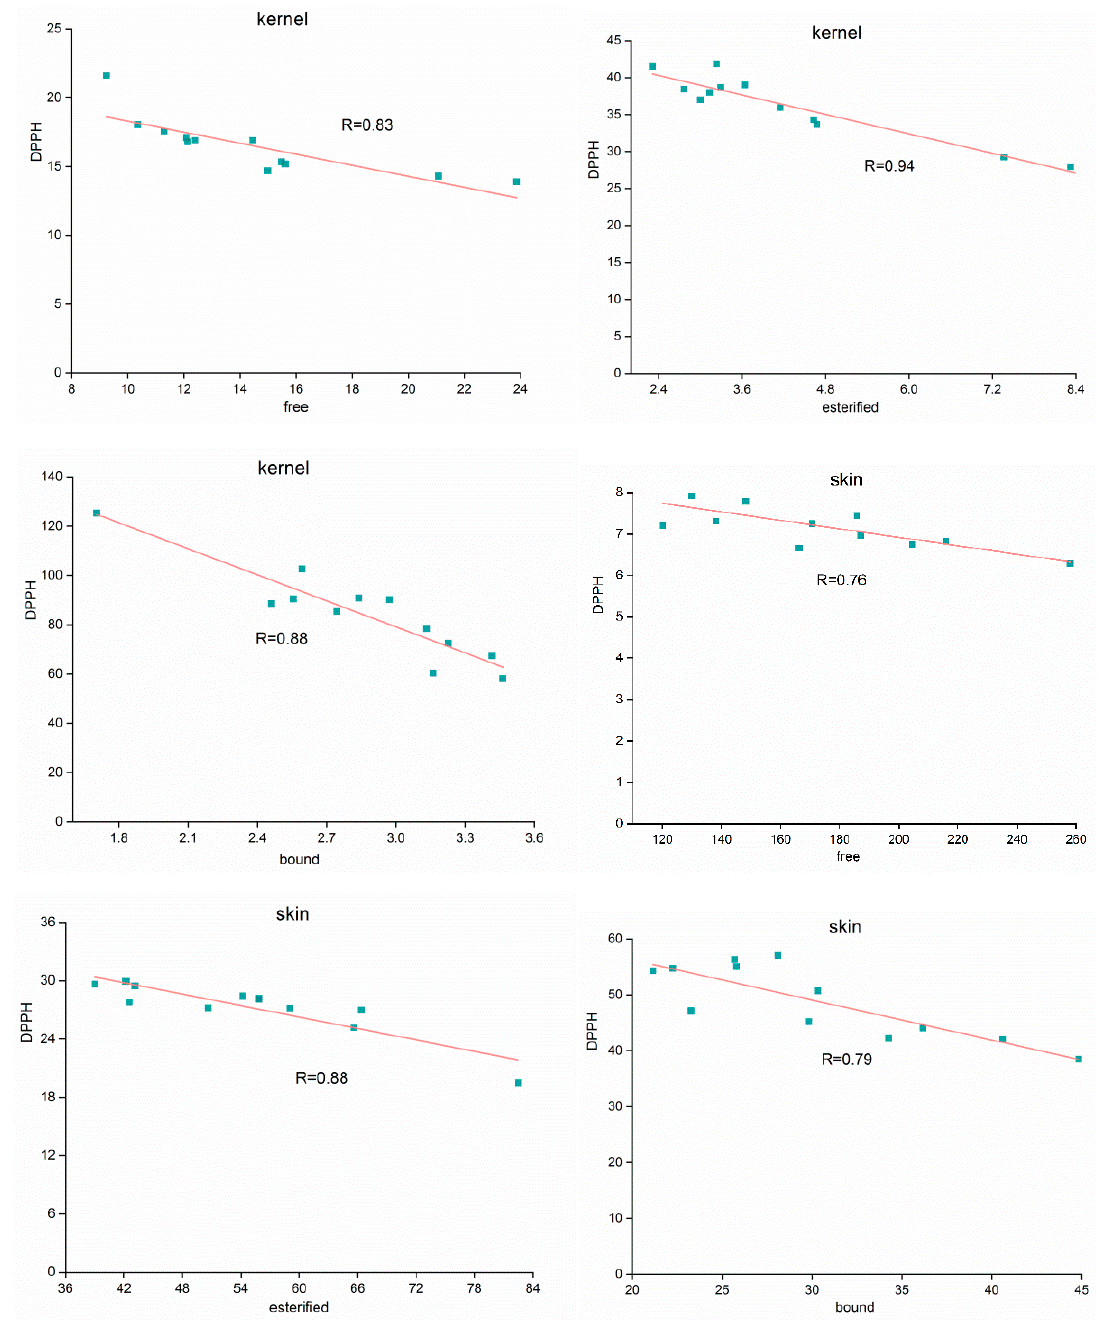
Figure 2. The linear correlations between antioxidant activity assays determined using DPPH scavenging methods and TPC content in free, esterified, and bound forms in kernel and skin of walnut. We also discovered that differences in key phenolic antioxidants influenced the an- tioxidant activity of the different cultivars. In the bound form, cultivars “L7” and “L12”, in particular, demonstrated significantly high antioxidant activities (Table 1). In the two cultivars, the total content of key antioxidants (ellagic acid, gallic acid, and epicatechin) in the bound form in the skin was higher than in the others. Moreover, cultivar “L12” (which had the highest antioxidant activity) contained high levels of key antioxidants (ellagic acid, sinapic acid, syringic acid, and rutin) in the free form in the kernel, as well as the esterified forms of ellagic acid, gallic acid, caffeic acid, and ferulic acid, respectively. In turn, there were no significant differences ( p > 0.05) between the cultivars in the antioxidant